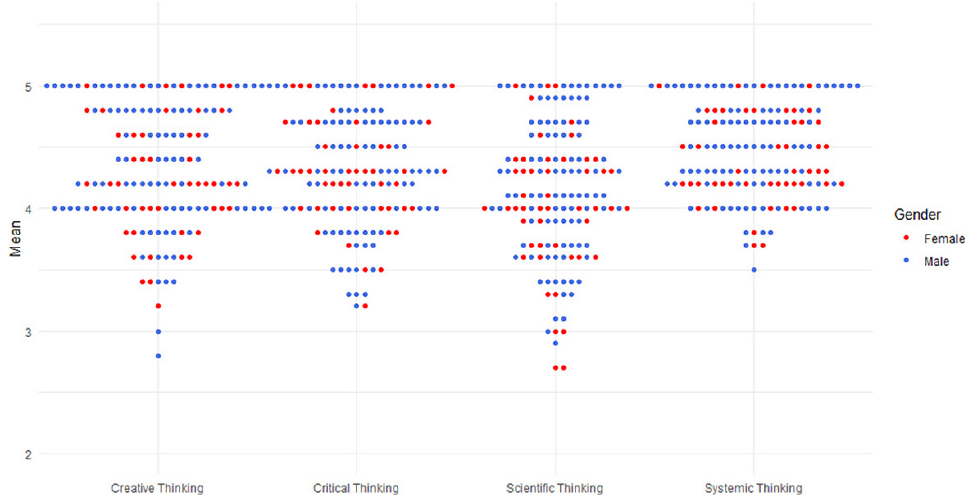
Fig. 4. Complex thinking: beeswarm analysis of sub-competencies by